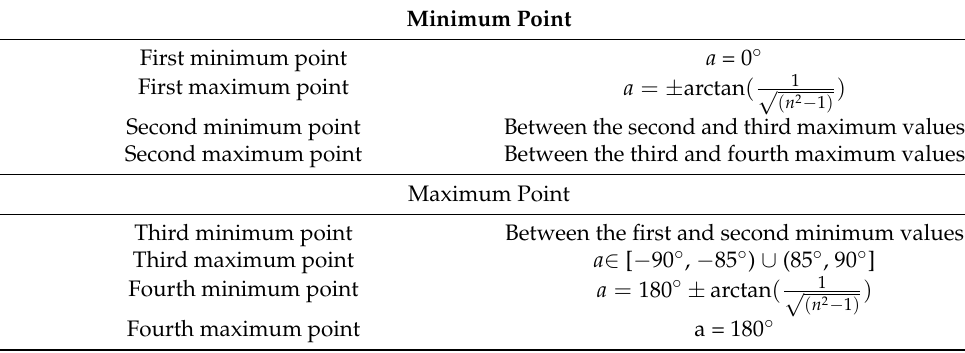
Table 3. Distribution law of extreme points.